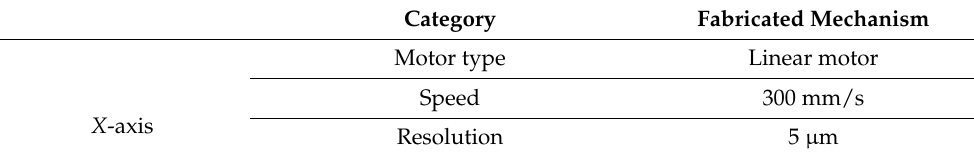
Table 2. Mechanical part performance.